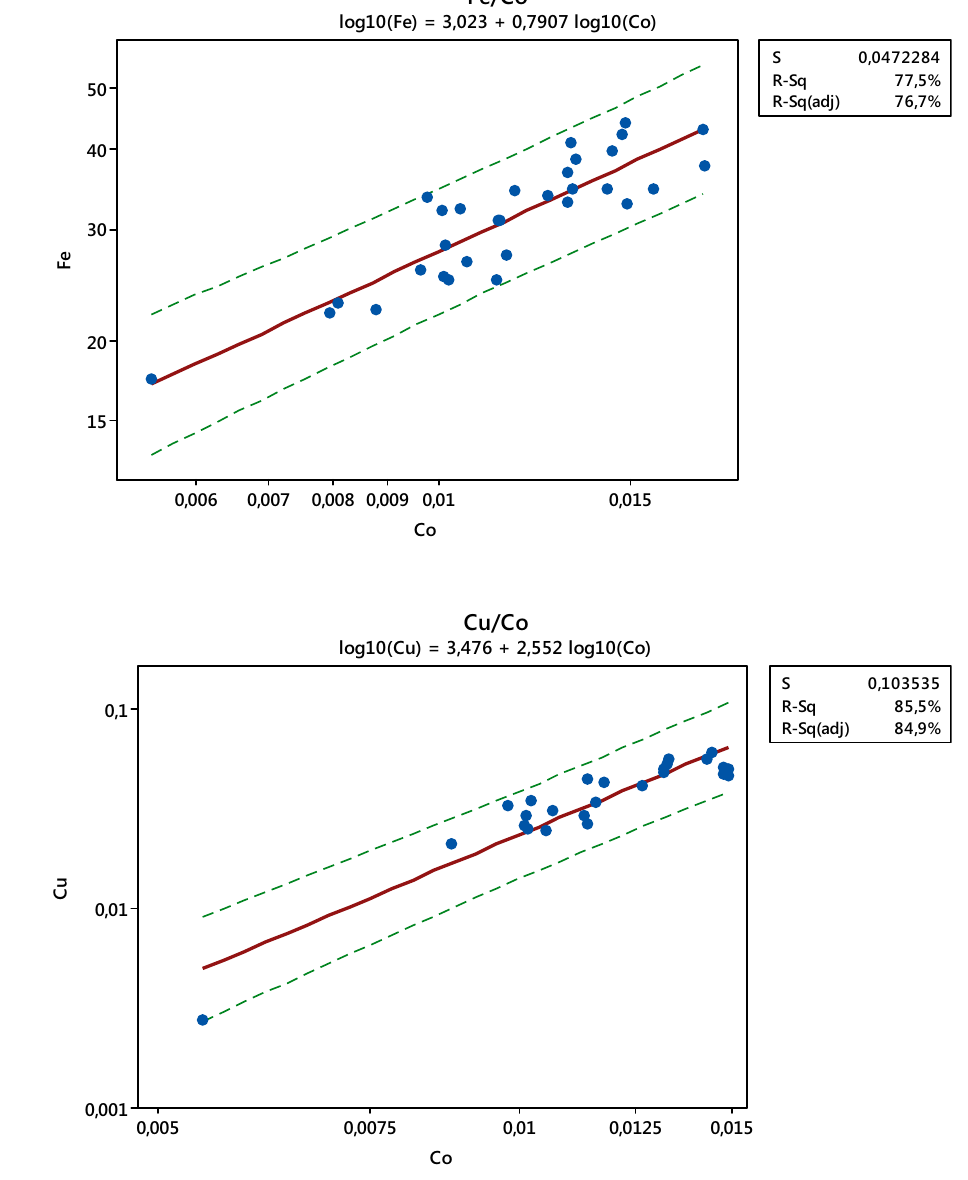
Fig. 6 Linear regression graph of iron background concentra- tion determination ( R 2 = 77,5%)